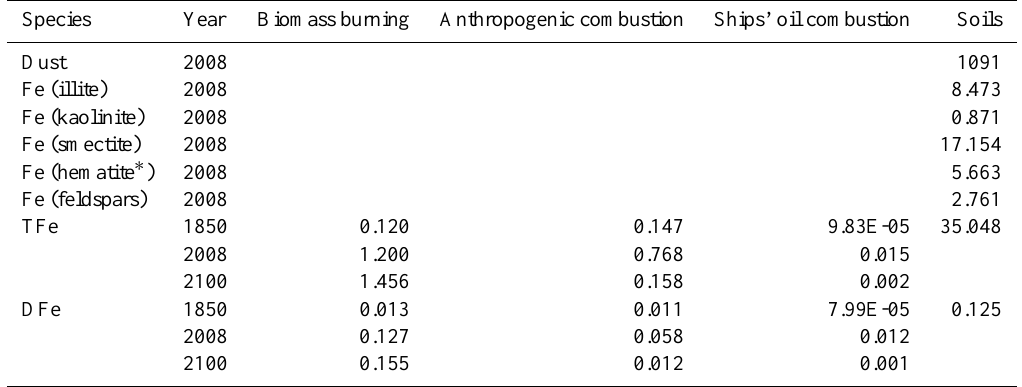
Table 1. Emissions of dust (in Tgyr − 1 ), Fe contained in dust-minerals (illite, kaolinite, smectite, hematite and feldspars; in Tg-Feyr − 1 ) and TFe and DFe (in Tg-Feyr − 1 ) used in TM4-ECPL for (a) present (year 2008), (b) past (year 1850) and (c) future (year 2100)